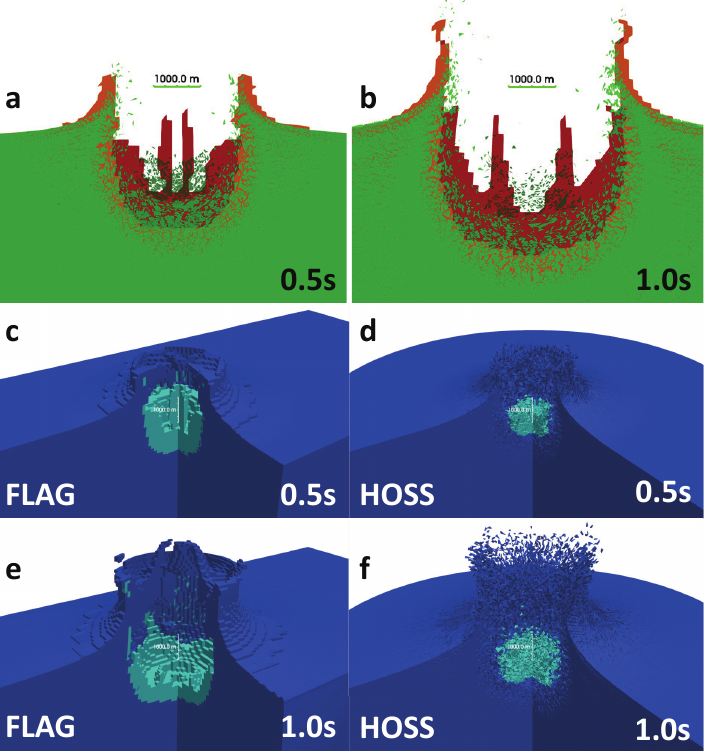
Figure 7. FLAG and HOSS simulations overlaid to show differences in the crater profiles from a 20 km/s normal impact ( a , b ) at 0.5 s and 1.0 s. The FLAG simulations are represented with an orange target material and red impactor. HOSS simulations are shown with a green target material and dark green impactor. ( c – f ) show 3D cross-sections of the impact scenario at 0.5 s and 1.0 s, where dark blue and cyan represent the target and impactor, respectively. The length of the horizontal green bar ( a , b ) and of the vertical white bar ( c – f ) shown represents a distance of 1000